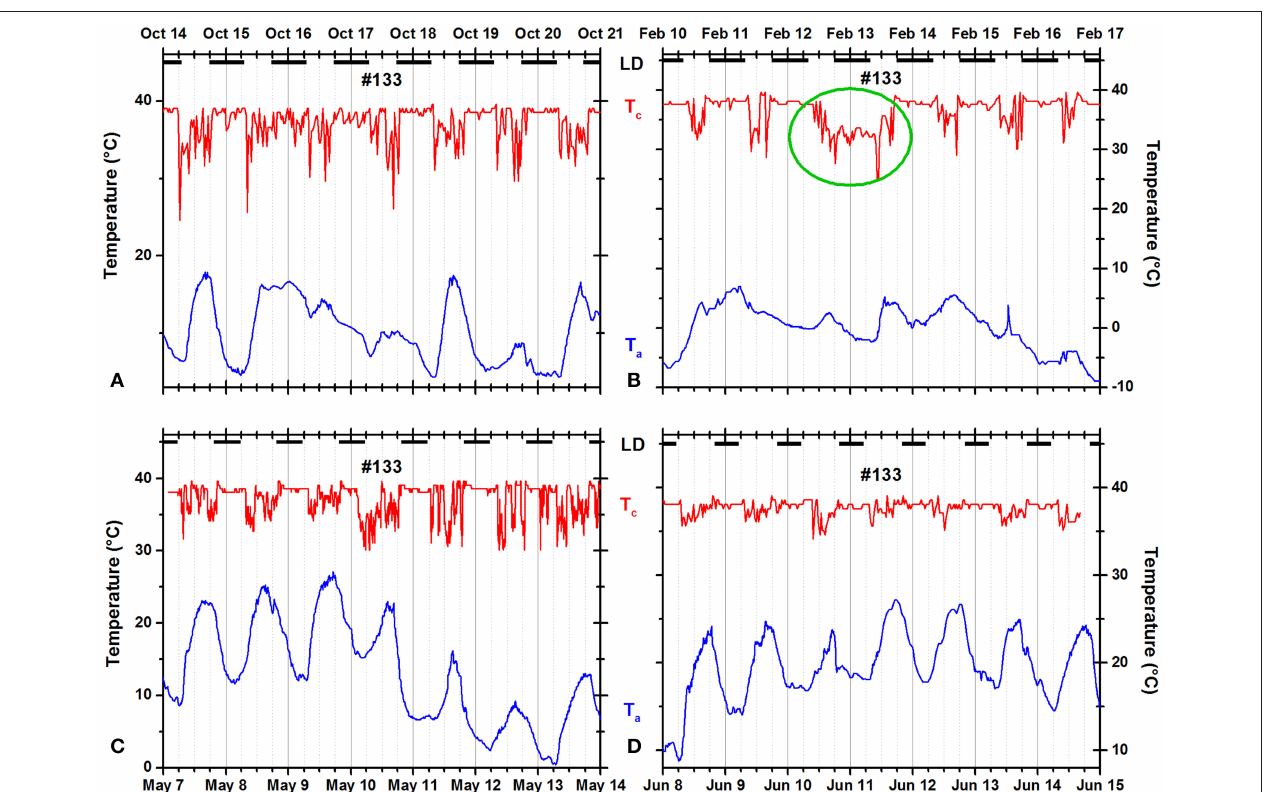
FIGURE 10 | Records of ambient temperature (T a , blue) and neck skin temperature (T c , red) for fox squirrel #133 in (A) fall, (B) winter, (C) spring, and (D) summer. The dark horizontal bars at the top of each panel indicate the duration of the dark phase of the natural light–dark cycle. The green oval in (B) marks a day when the squirrel did not visit its insulated nest for more than